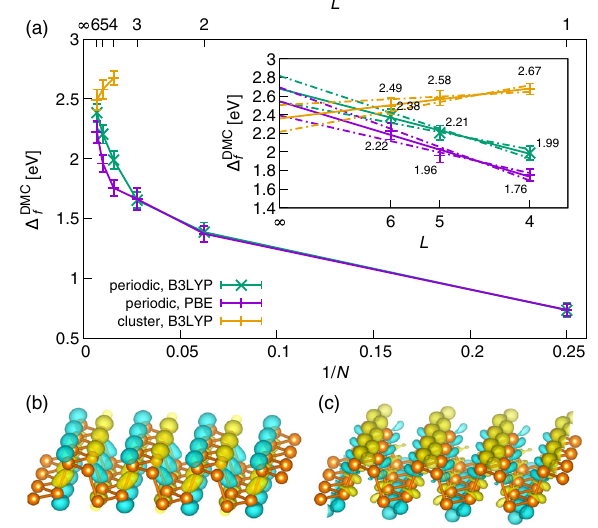
FIG. 2. (a) Finite-size scaling of the computed fundamental gap Δ N in the periodic supercell (green f , with the number of atoms line, DMC@B3LYP; purple line, DMC@PBE) and in the cluster approach (yellow line, DMC@B3LYP) along the series of L × L supercell approximants, L ¼ 1 – 6 for the periodic setup and L ¼ 4 – 6 in the cluster approach. The inset shows an enlargement of the scaling for large N with the dashed lines showing the linear extrapolation to the infinite-size limit. (b) B3LYP DFT HOMO (left) and (c) LUMO (right) orbitals. Both are Γ -point Bloch states, HOMO being a superposition of bonding orbitals [mostly σ ð p Þ ] along the vertical P – P bonds while LUMO is its z antibonding